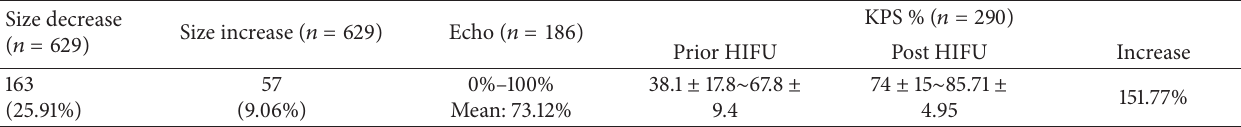
Table 3: Statistics of tumor size change, echogenicity in B-modeultrasound image, and Karnofsky performance scale (KPS) score of advanced pancreatic cancer patients undergoing HIFU therapy.